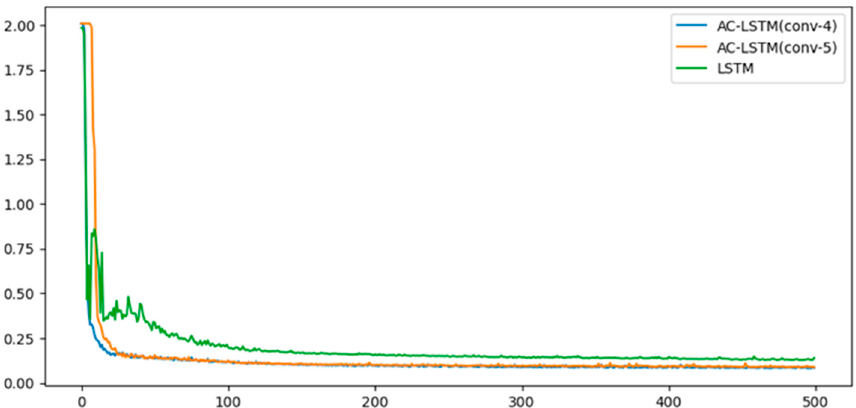
Figure 16. Cross entropy per epoch of different methods.